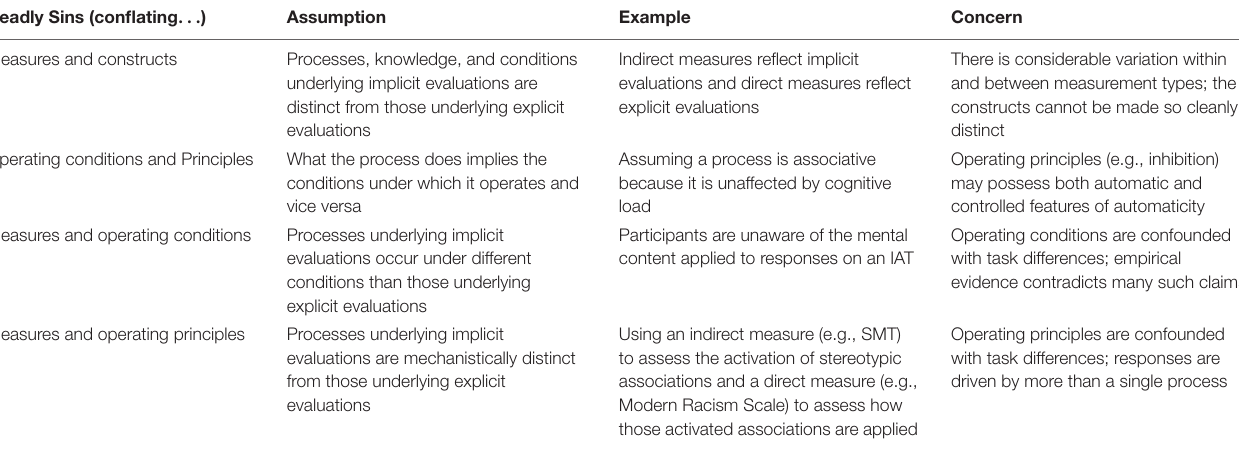
TABLE 1 | The four deadly sins of implicit attitude research. Deadly Sins (conflating ...